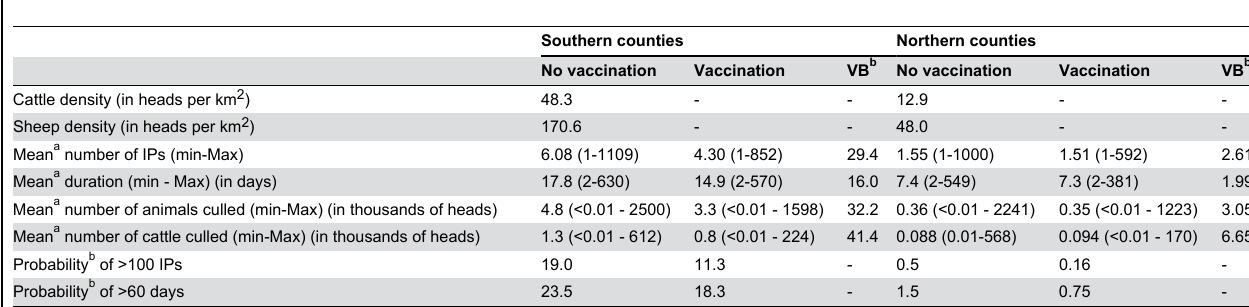
Table 1. Epidemic impact and vaccination benefit for FMD epidemics occurring in Southern or Northern counties of